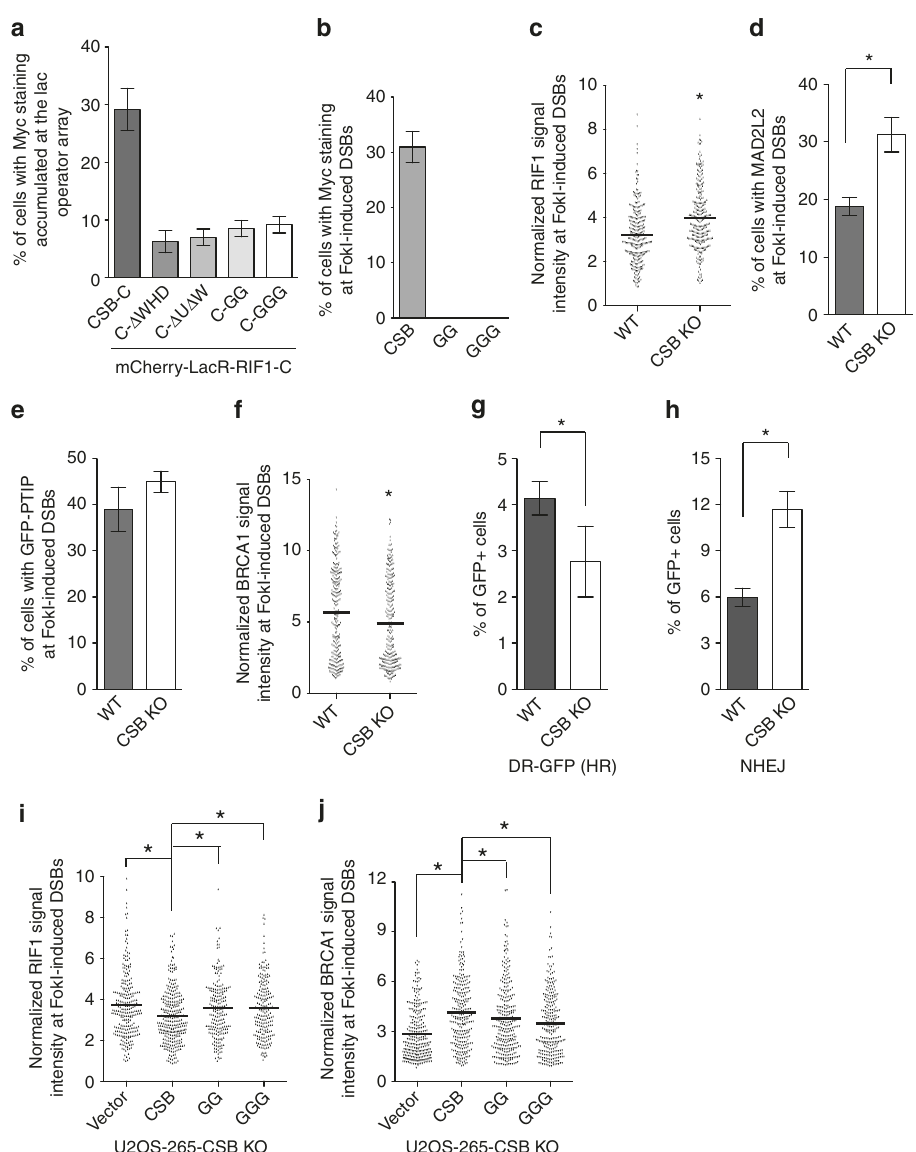
Fig. 3 CSB interacts with RIF1 and inhibits RIF1 at DSBs. a Quanti fi cation of the percentage of cells exhibiting Myc staining accumulated at the lac operator array in U2OS-265 cells co-transfected with indicated alleles. A total of 250 cells positive for Myc staining were scored for each independent experiment in a blind manner. SDs from three independent experiments are indicated. b Quanti fi cation of the percentage of cells exhibiting Myc staining at the site of FokI-induced DSBs. A total of 250 U2OS-265 cells expressing various Myc-tagged CSB alleles as indicated were scored for each independent experiment in a blind manner. SDs from three independent experiments are indicated. c Quanti fi cation of the intensity of RIF1 signal at FokI-induced DSBs. The respective numbers of cells analyzed for parental and CSB KO were 275 and 277. * P < 0.05 (Mann – Whitney test). d Quanti fi cation of the percentage of cells exhibiting MAD2L2 at FokI-induced DSBs. A total of 500 – 550 cells were scored for each independent experiment in a blind manner. SDs from three independent experiments are indicated. * P < 0.05 (Student t test). e Quanti fi cation of the percentage of cells exhibiting GFP-PTIP at FokI-induced DSBs. A total of 500 cells were scored for each independent experiment in a blind manner. SDs from three independent experiments are indicated. f Quanti fi cation of the intensity of BRCA1 signal at FokI-induced DSBs. The respective numbers of cells analyzed for parental and CSB KO were 282 and 294. * P < 0.05 (Mann – Whitney test). g HR-mediated repair of I-SceI -induced DSBs in U2OS-DR-GFP WT and CSB-KO cells. SDs from three independent experiments are indicated. * P < 0.05 (Student t test). h NHEJ-mediated repair of I-SceI -induced DSBs. SDs from three independent experiments are indicated. * P < 0.05 (Student t test). i Quanti fi cation of the intensity of RIF1 signal at FokI-induced DSBs. The respective numbers of cells analyzed for the vector alone, Myc- CSB, Myc-CSB-GG and Myc-CSB-GGG were 298, 304, 204, and 209. * P < 0.05 (Mann – Whitney test). j Quanti fi cation of the intensity of BRCA1 signal at FokI-induced DSBs. The respective numbers of cells analyzed for the vector alone, Myc-CSB, Myc-CSB-GG and Myc-CSB-GGG were 279, 270, 291, 258. * P < 0.05 (Mann – Whitney